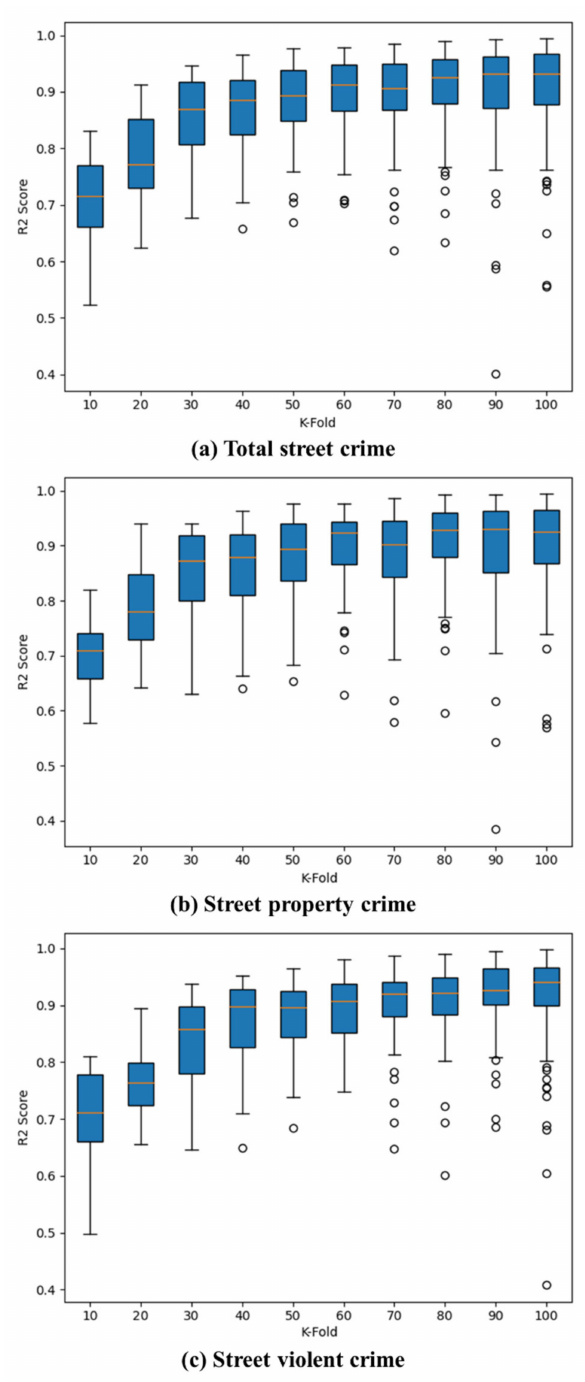
Figure 6. Cross-validation R 2 score of different fractions of training data for the regression